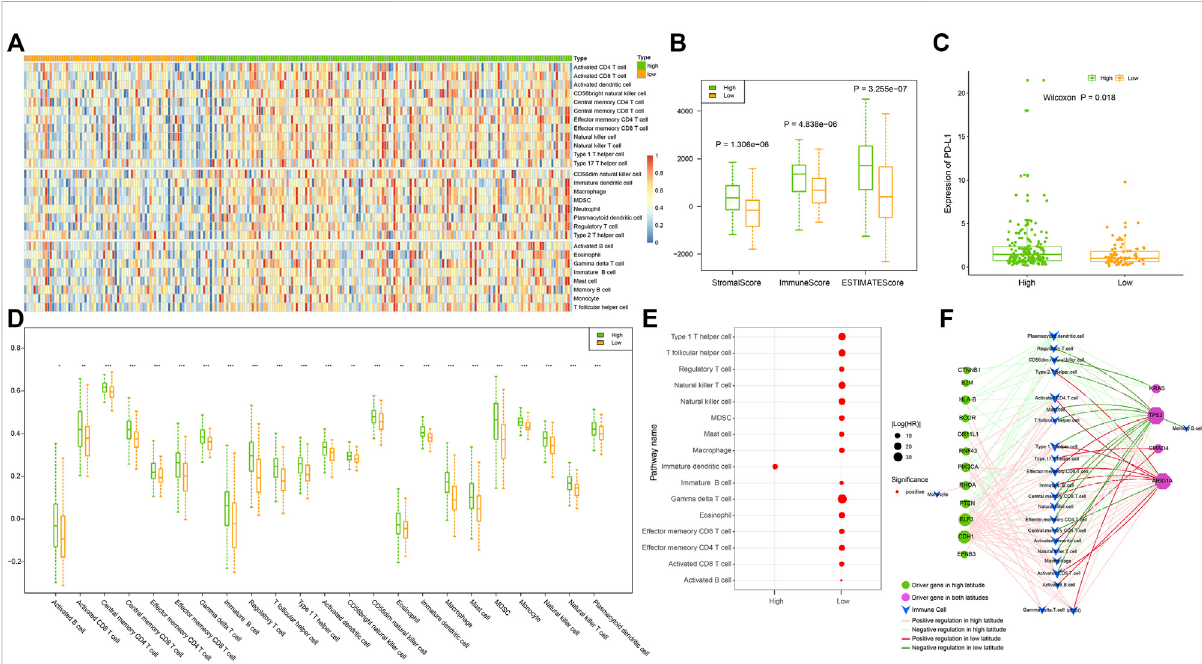
FIGURE 7 omparison of samples in high and low latitudes at the immune level. (A) In fi ltration of 28 immune cells in samples. (B) Stromal, immune, and ESTIMATE scores ofsamplesevaluated usingthe “ estimate ” method. (C) Expression ofPD-L1 insamples. (D) Immunecells withsigni fi cantly different in fi ltration between two sample groups; p values of less than 0.05, 0.01, and 0.001 were marked with “ * ” , “ ** ” , and “ ***, ” respectively. (E) Prognostic immune cells. (F) Driver gene-related immune cell network. The nodes and edges were colored based on the adjacent fi gure